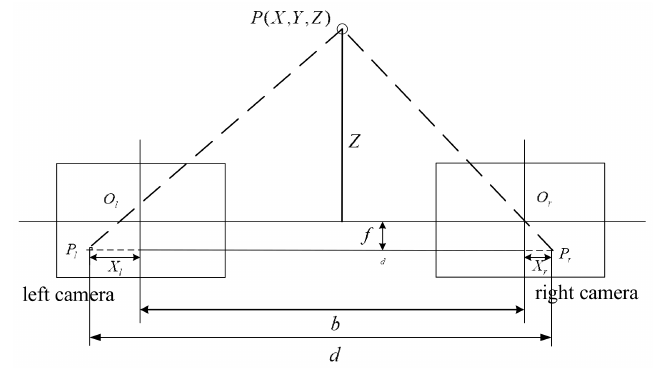
Figure 3. Principle diagram of ideal binocular vision